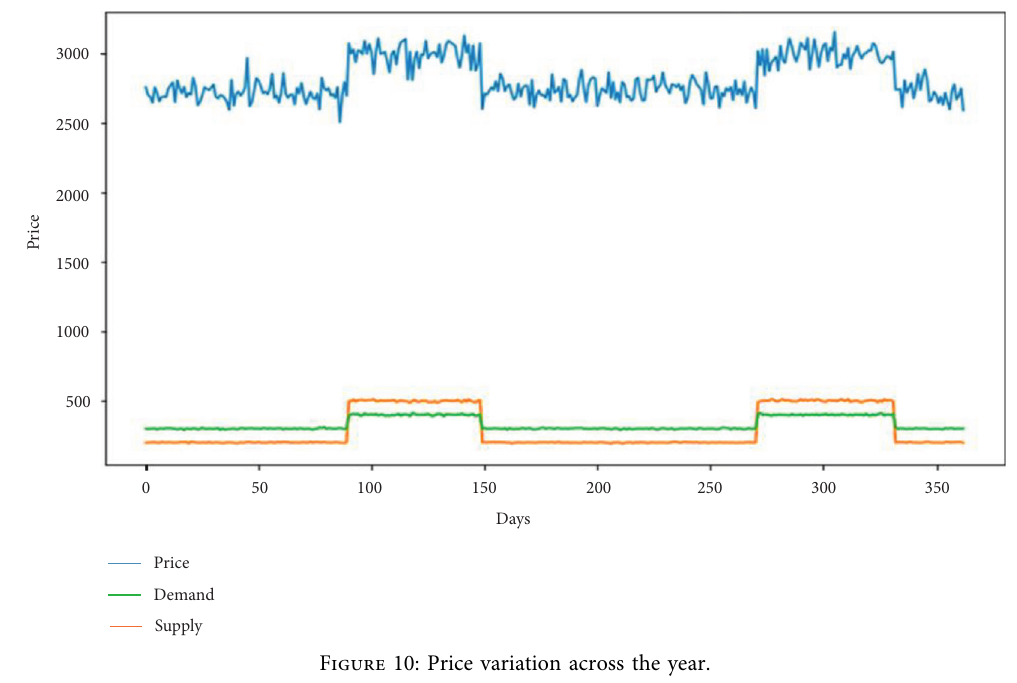
Figure 10: Price variation across the year.